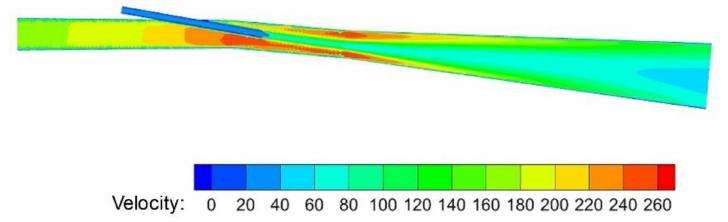
Figure 3. Velocity distribution in the blowpipe-tuyere-combustion